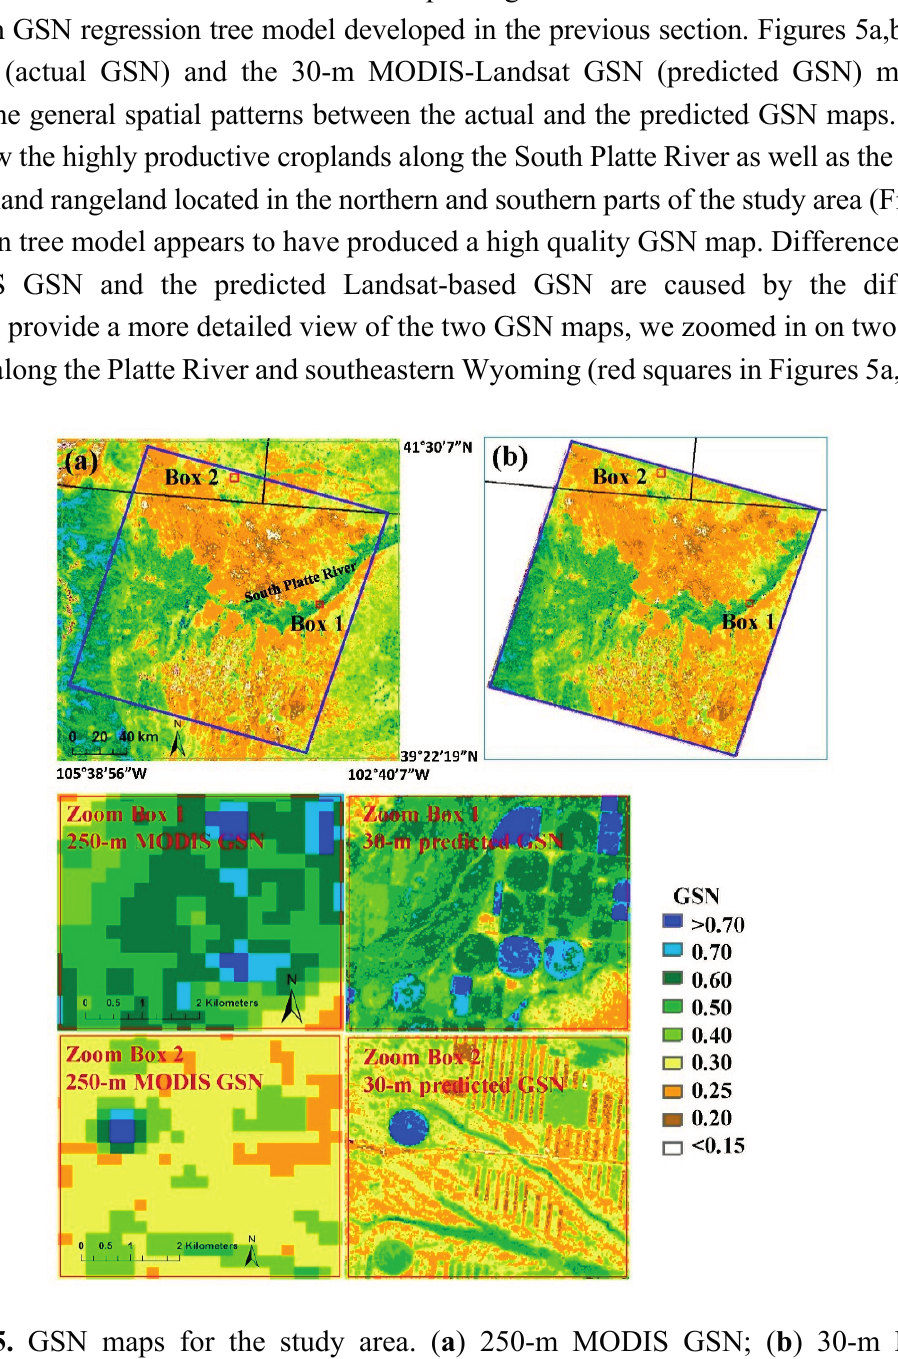
Figure 5. GSN maps for the study area. ( a ) 250-m MODIS GSN; ( b ) 30-m MODIS Landsat-based predicted GSN. Locations of the two zoomed boxes are shown in Figures 5a,b (red squares). The main vegetation cover types are irrigated croplands and grasslands for Box 1 and row crops and rangeland for Box